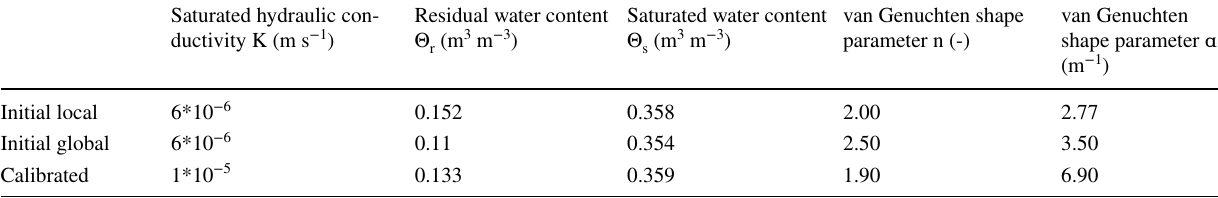
Table 5 Final hydraulic soil parameter set for soil 2 based on calibration